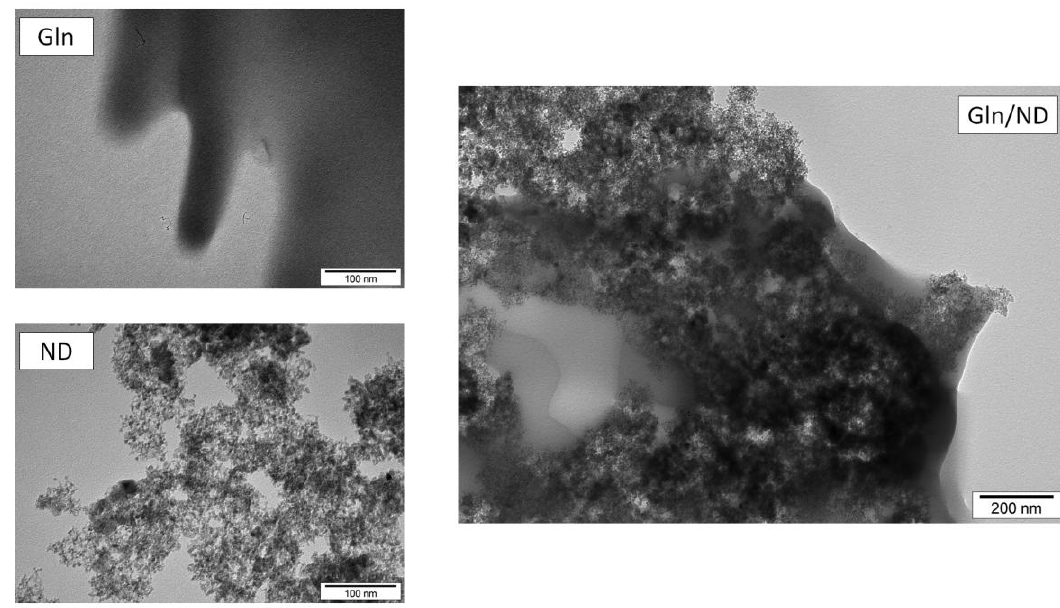
Figure 1. Transmission electron microscopic images of nanoparticles of diamond (ND), L -glutamine (Gln), and bio-complex of Gln with ND